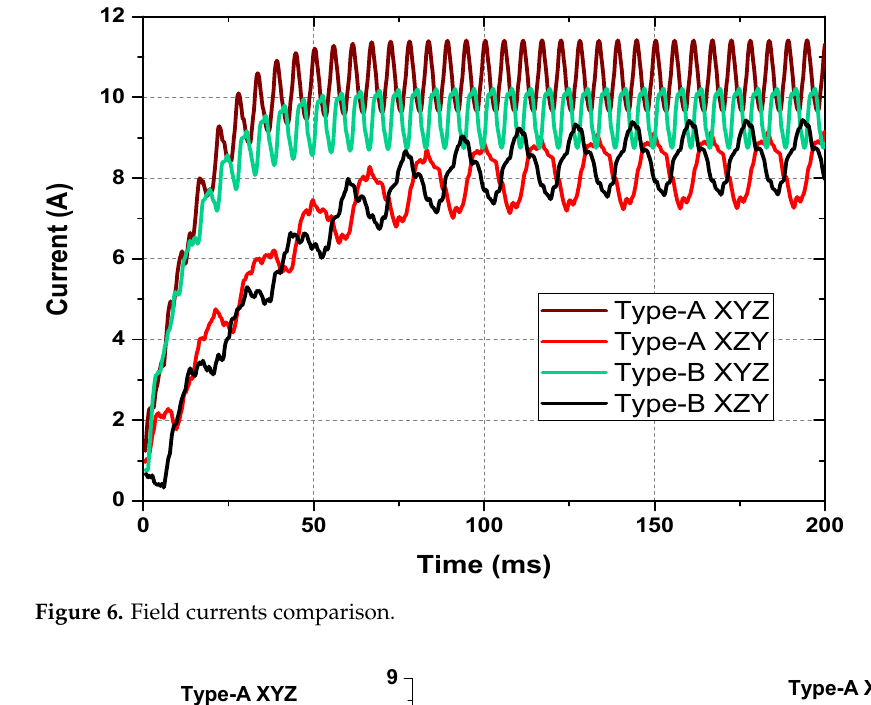
Figure 5. Harmonic currents comparison.